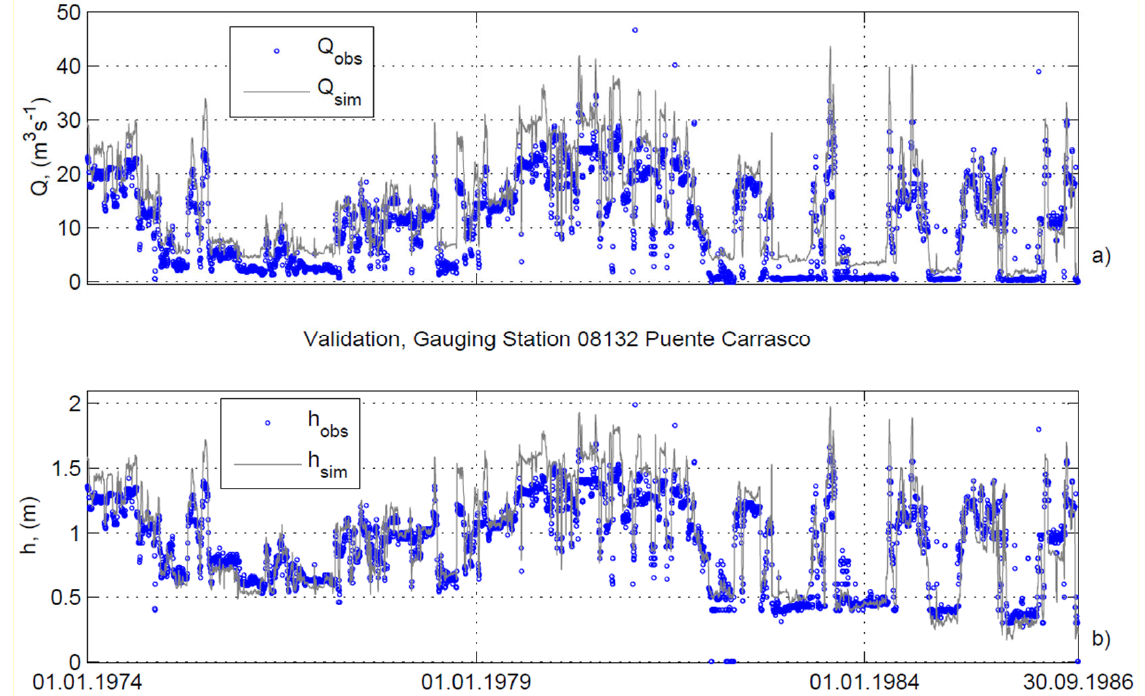
Figure 6. Simulated and observed time series. Daily mean observed (grey diamonds) and modeled (black line) time series for discharge ( a ) and water depths ( b ) at Puente de Carrasco gauging station within time periods with available data, used for the model performance evaluation. Table 3. Calibration and validation statistical performances at Los Frailes and Puente de Carrasco stations (simulated versus observed time series), represented by correlation coefficient (R), deter ‐ mination coefficient (R 2 ), Nash–Sutcliffe efficiency (NSE), and root mean square error (RMSE) for discharge Q (m 3 s − 1 ) and depths h (m) time series, calculated within periods with availability for observed data.